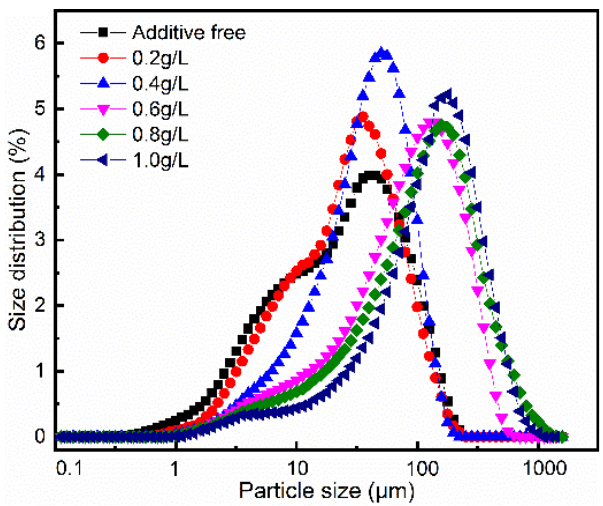
Figure 4. Grain size distribution curve of Mg(OH) 2. Table 2. Particle size distribution data of electrolytic products with different PEG